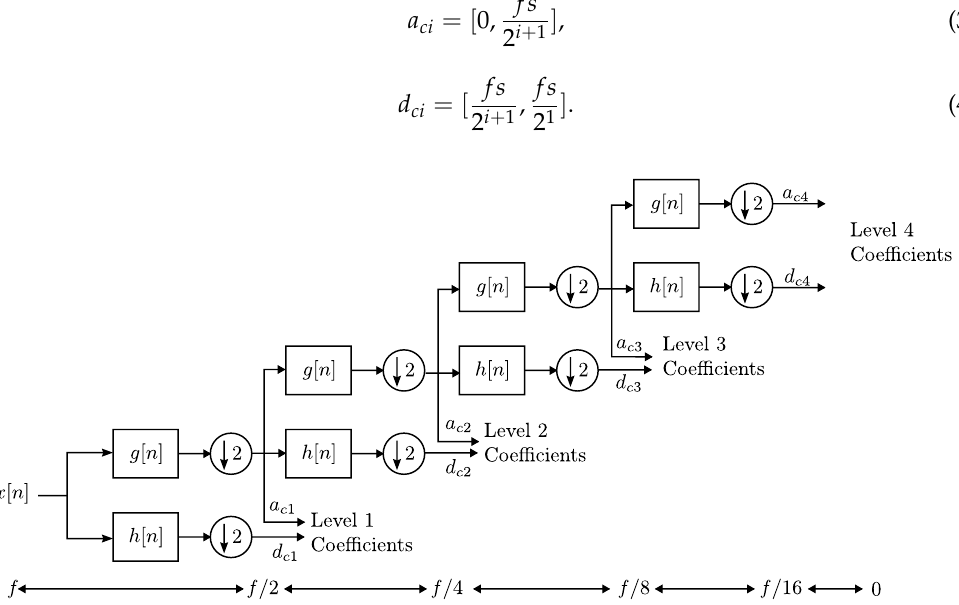
Figure 1. Representation of the Mallat algorithm for a decomposition level four. In the lower part, it is shown how the frequency of the signal is divided in each decomposition